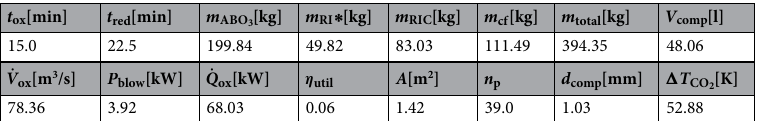
Table 10. Chosen case EuNiO 3 -SrCO 3 (60% 90 Sr) calculation results; T ox = 300 ◦ C , T red = 425 ◦ C . ∗ m 90 Sr ( 60% ) of 49.8kg corresponds to a thermal power